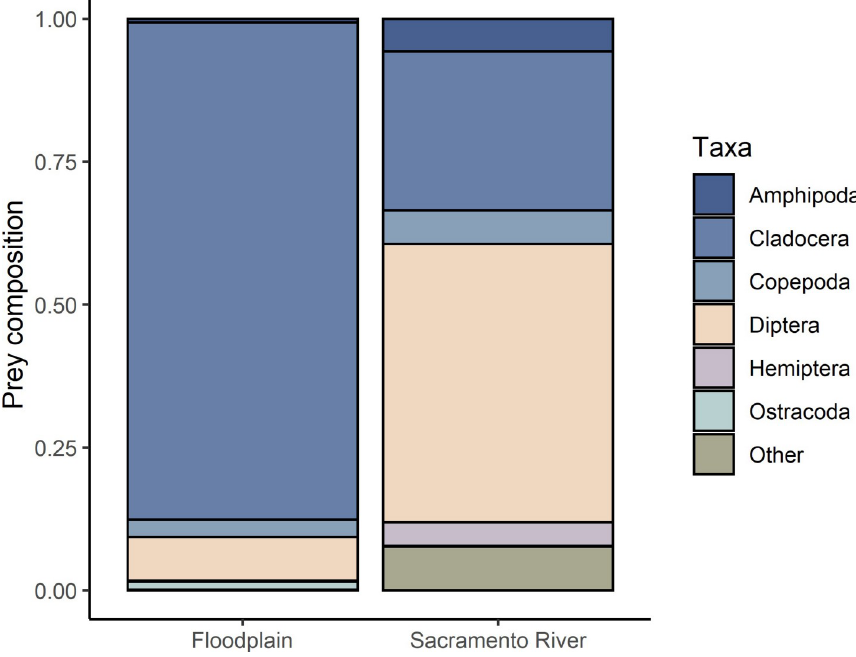
Fig 2. Relative diet composition from fish captured in the floodplain and adjacent river by taxa, all years averaged together (N = 365).